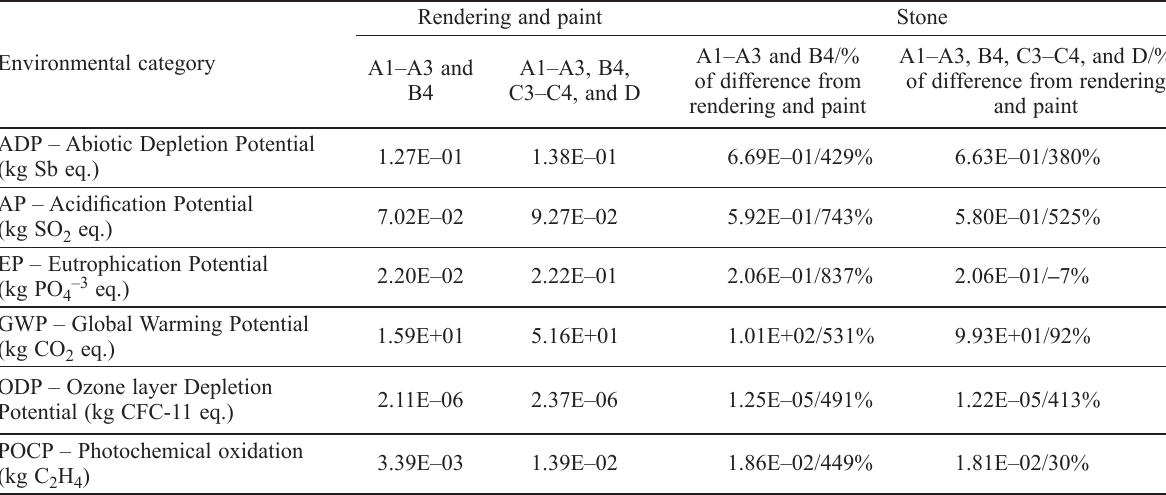
table 8. lCA results of each alternative using standard SlP